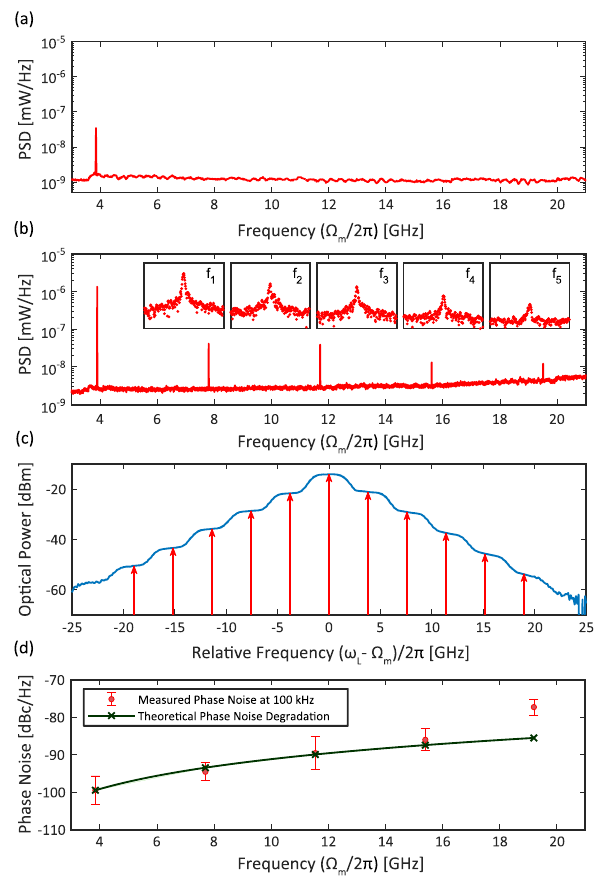
Figure5: Opticalfrequencycomb(OFC)generationintheOMcrystal cavity at P in = 3.38 mW.